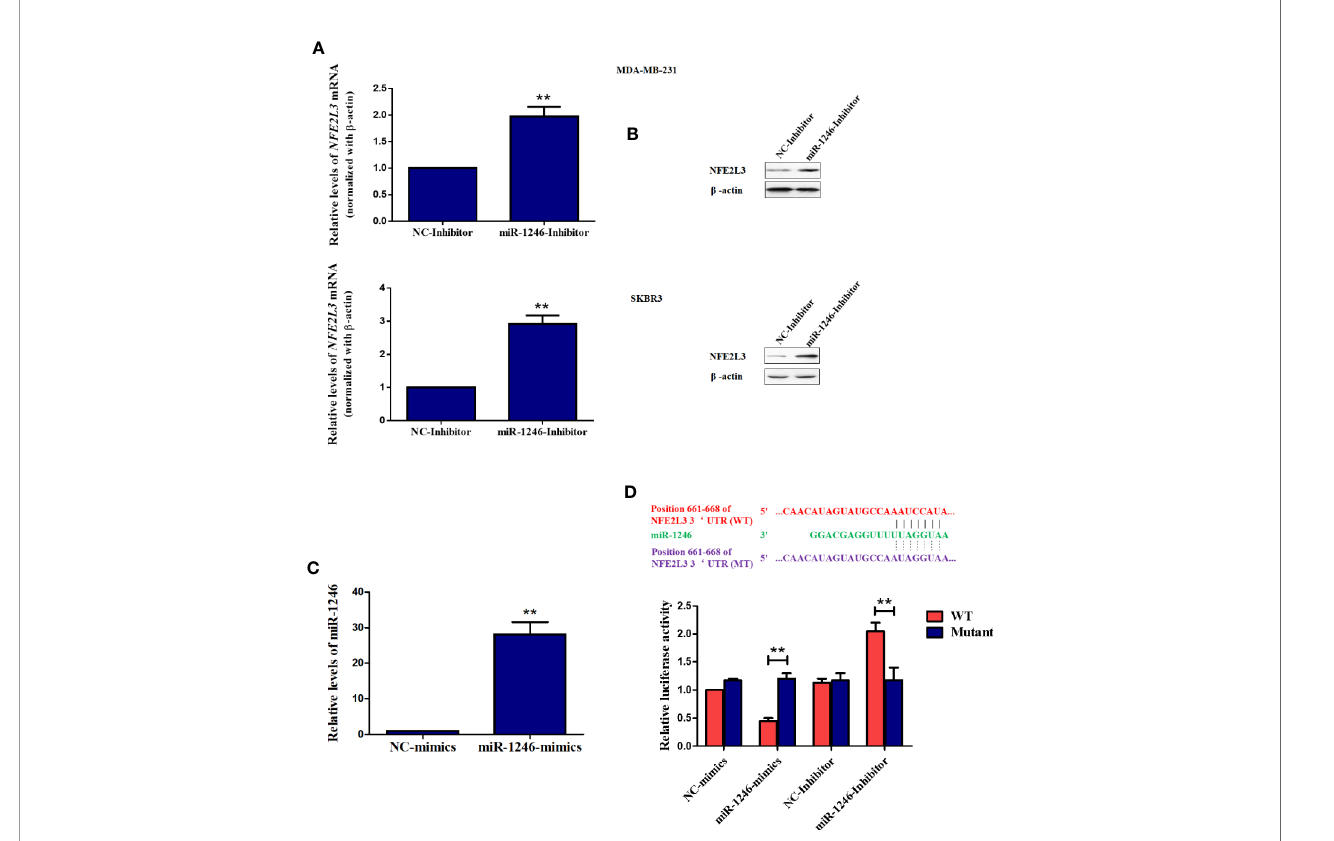
FIGURE 4 | NFE2L3 is a novel target gene of miR-1246 in breast cancer cells. (A, B) After MDA-MB-231 and SKBR3 cells were transfected with miR-1246 inhibitor or NC, NFE2L3 mRNA levels were determined using RT-PCR (A) and NFE2L3 protein expression was examined using western blotting (B, C) After MDA-MB-231 cells were transfected with miR-1246 mimics or NC, miR-1246 expression levels were determined using RT-PCR. (D) 3 ’ UTR assay was performed to con fi rm the regulatory relationship between miR-1246 and NFE2L3 using wild-type or mutant plasmids. Data are presented as mean ± SD, n=3. **P < 0.01 vs.